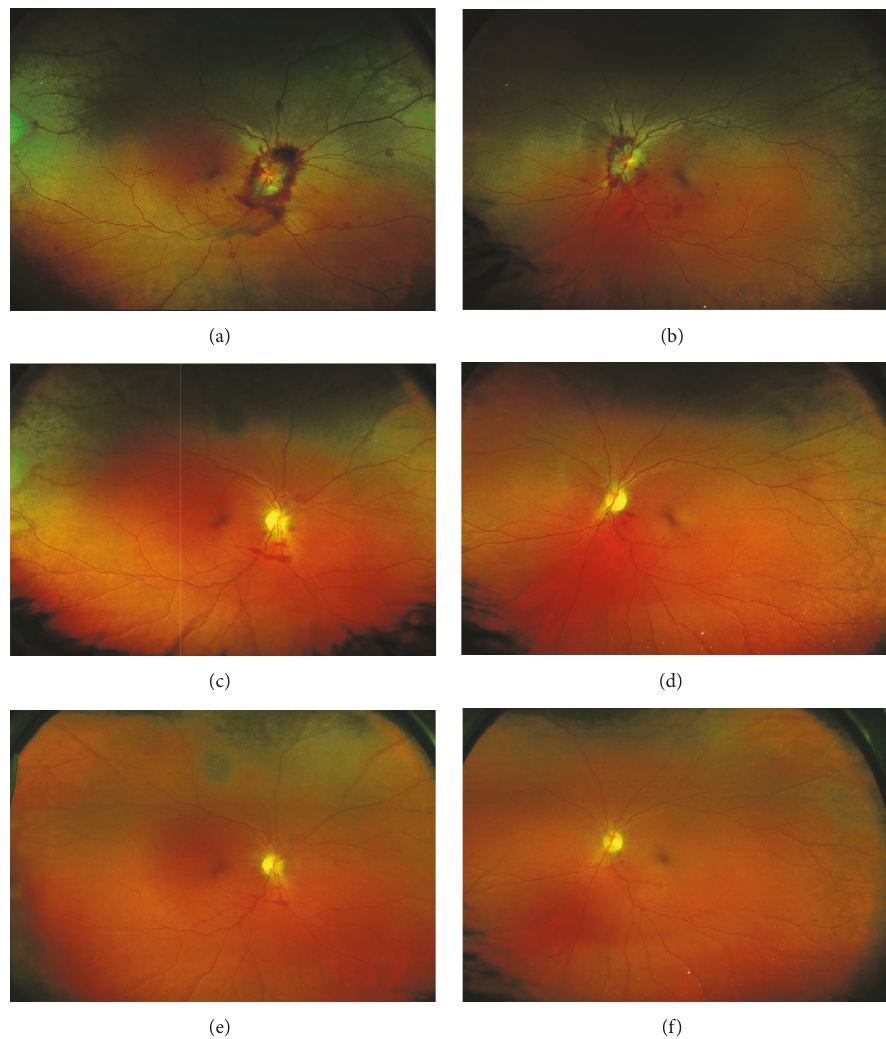
Figure 1: Optos Fundus Photos showing (a) right eye and (b) left eye at presentation showing preretinal hemorrhages, flame hemorrhages, and intraretinal blot hemorrhages with optic disc edema consistent with Terson syndrome. (c, e) Right eye and (d, f) left eye showing disc pallor consistent with optic atrophy and resolving hemorrhages with persistent inferior preretinal hemorrhages inferior to the disc at (c, d) 3-month follow-up and at (e, f) 4-month